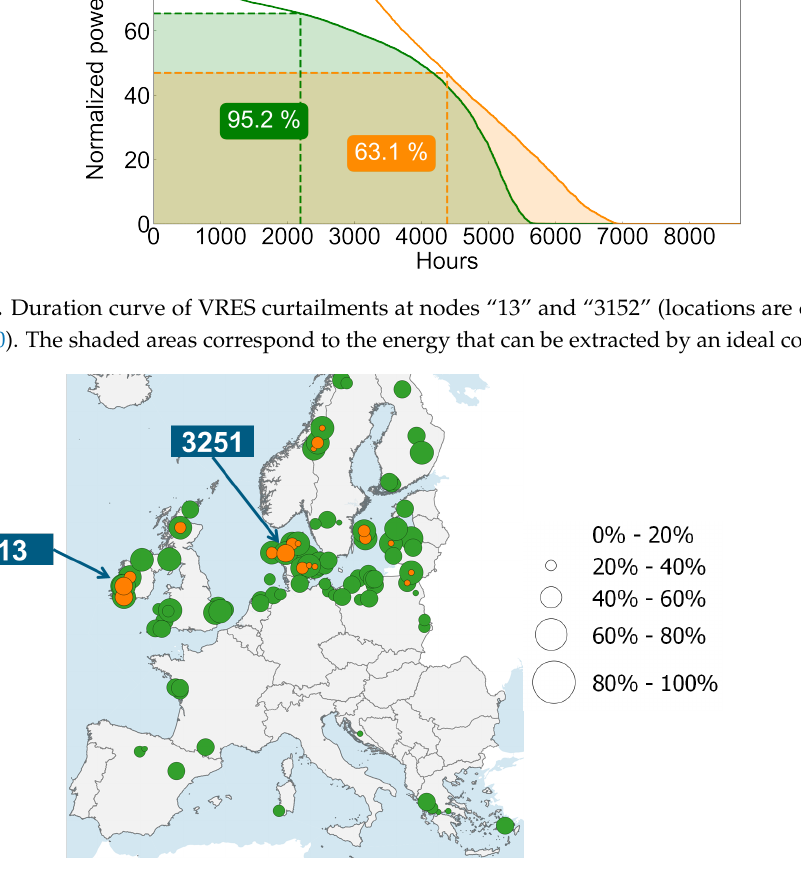
Figure 10. Normalized energy, extracted by ideal converters for the first 100 transmission nodes with the highest amount of total curtailments. The green and orange colors indicate converters with capacity corresponding to the 75th and 50th percentiles of the curtailments distribution,